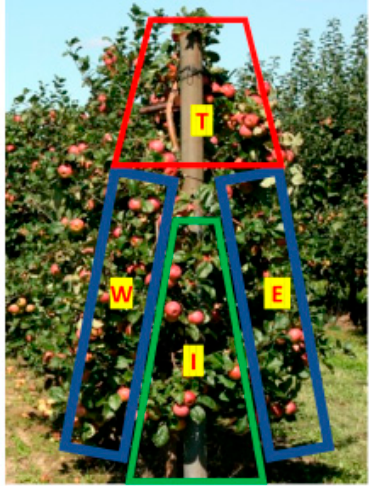
Figure 3. Ilustration of tested canopy positions, where T—top part of the canopy, W—west side, E—east side, I—inner part of the canopy (inside).